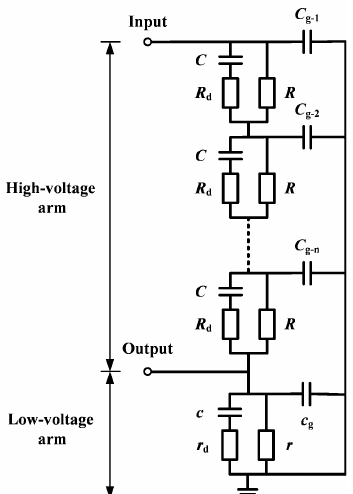
Figure 1. Circuit structure of resistive – capacitive voltage divider.